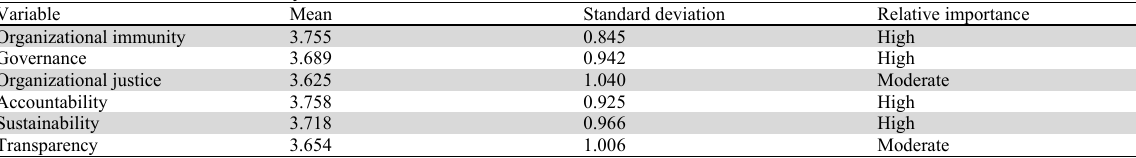
The arithmetic means of the study variables